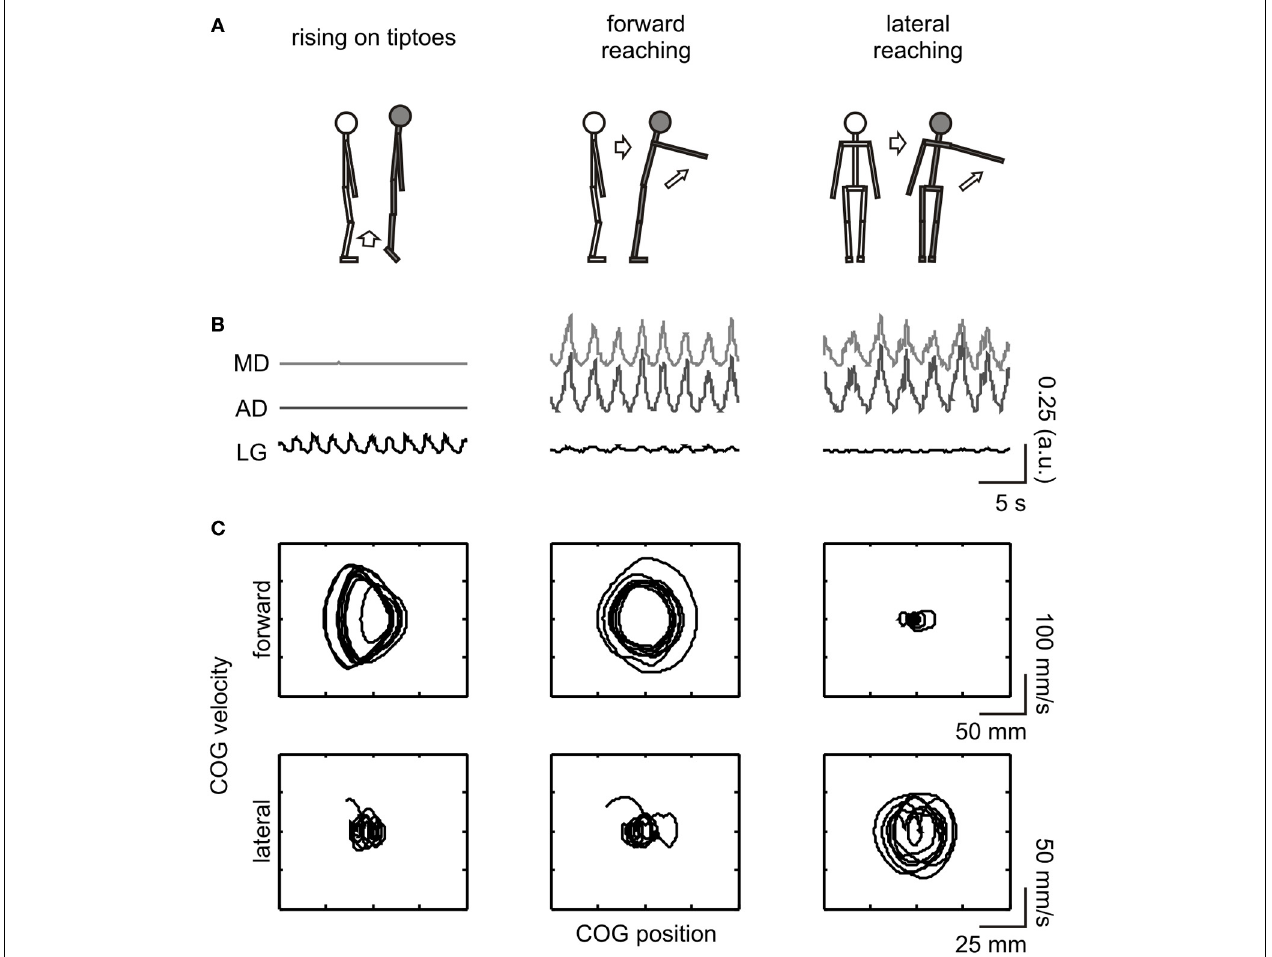
FIGURE 1 | Schematic illustration of the experimental procedure. From top to bottom: (A) depiction of the movements executed and imagined; (B) full-wave rectified EMG from the evaluated muscles [MD (light gray line) and AD (dark gray line) corresponds to the middle and anterior portion of the deltoid muscle, respectively, while LG (black line) refers to the lateral gastrocnemius]; (C) COG phase-plane plot in the forward- backward (upper row) and lateral (lower row) directions. EMG and COG